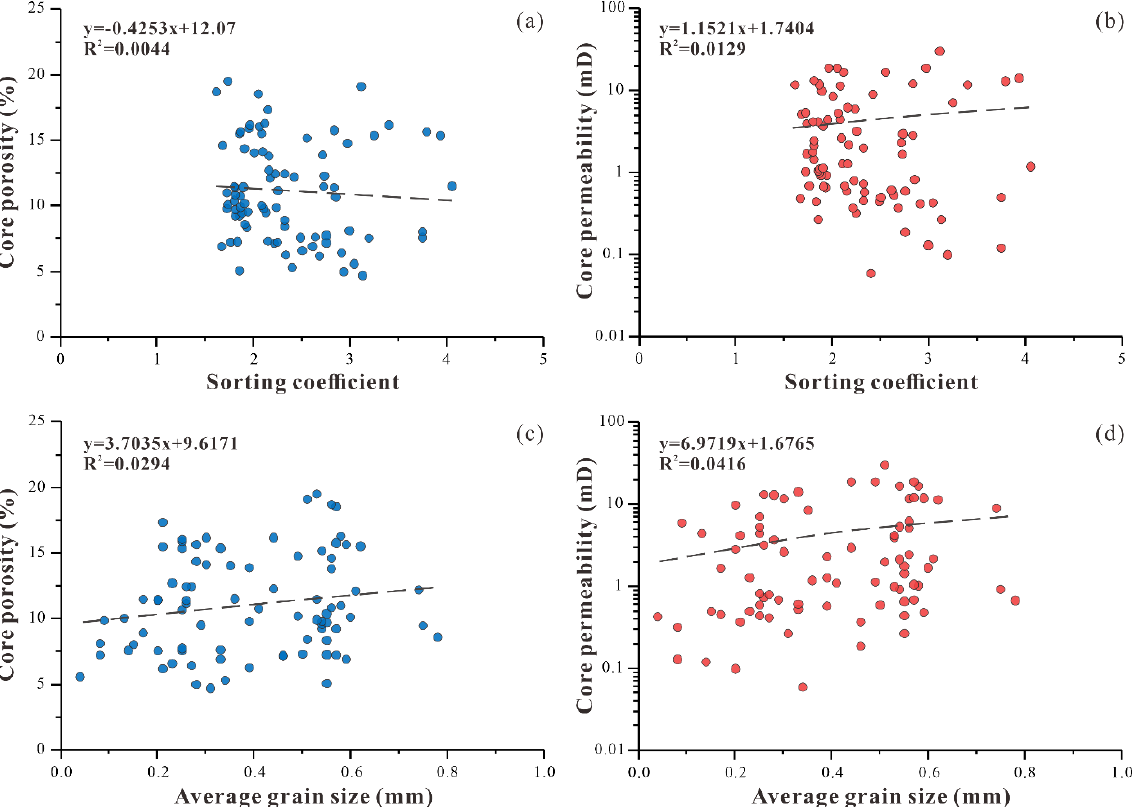
Figure 12. Relationship between sorting coefficient and average grain size and reservoir physical properties: ( a ) sorting coefficient and porosity; ( b ) sorting coefficient and permeability; ( c ) average grain size and porosity; ( d ) average grain size and permeability.